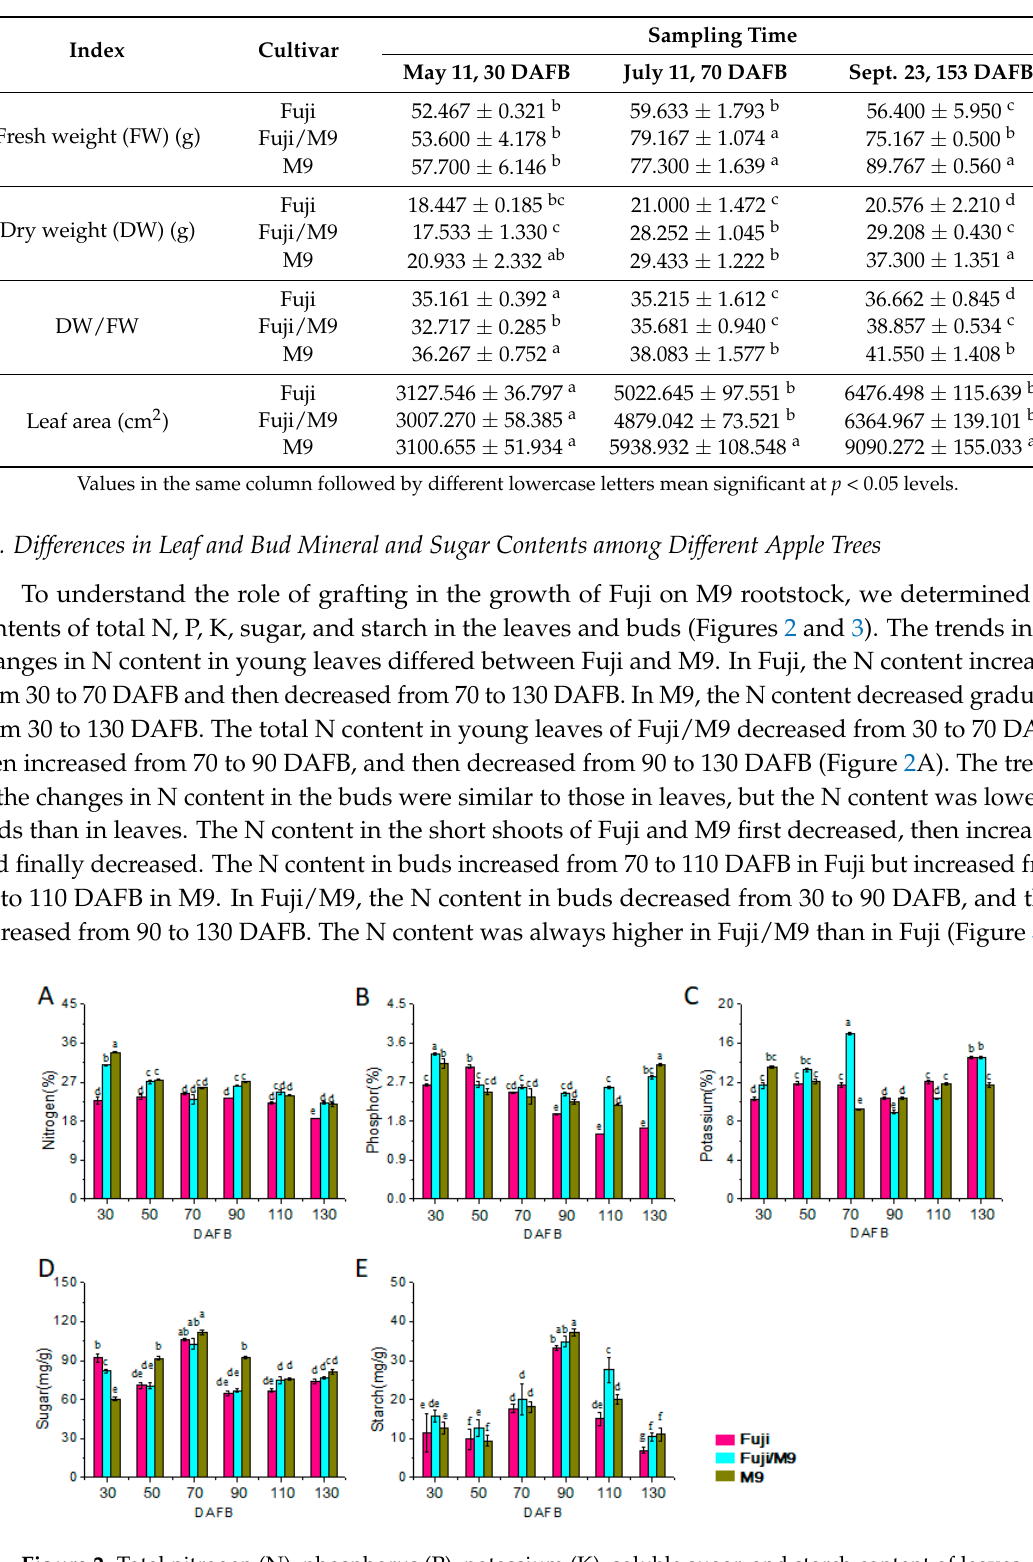
Table 1. Morphologic differences leaves of different apple combinations. DAFB, days after full blossom.